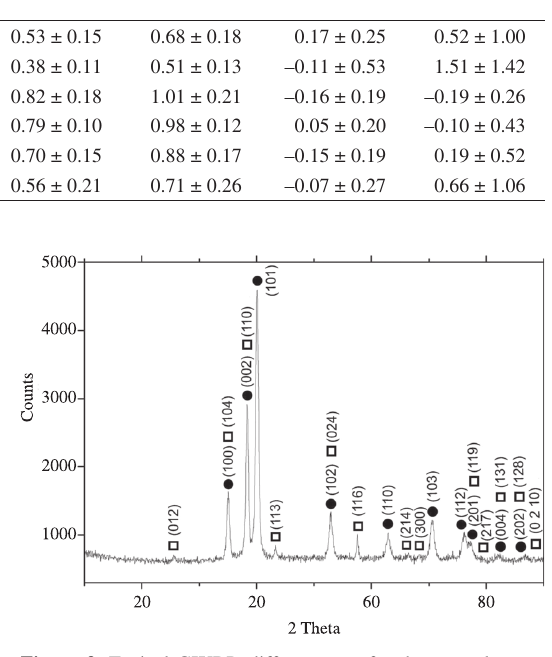
Figure 3. Typical GIXRD diffractogram for the control group sample, showing peak identification (Miller indices). Ti (circle), Al O (square). 2 3